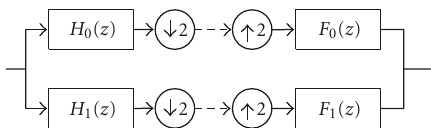
Figure 7: Two-band critically downsampled complex biorthogonal filterbank ( H 0 ( z ) and H 1 ( z ) are analysis filters; F 0 ( z ) and F 1 ( z ) are synthesis filters).